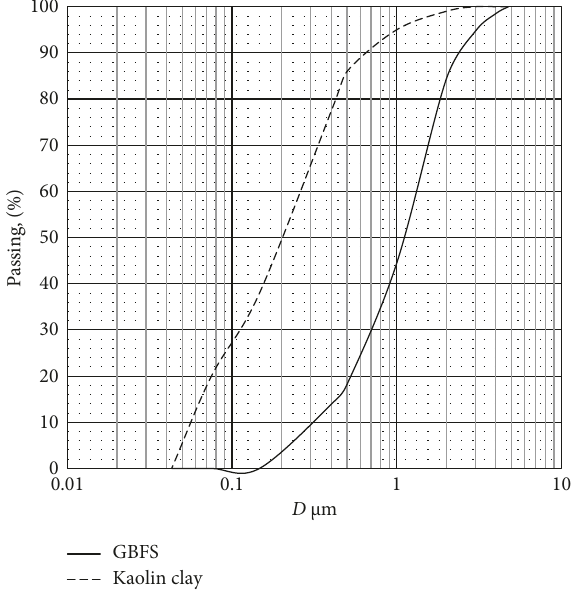
Figure 3: Particle size distribution of raw materials.